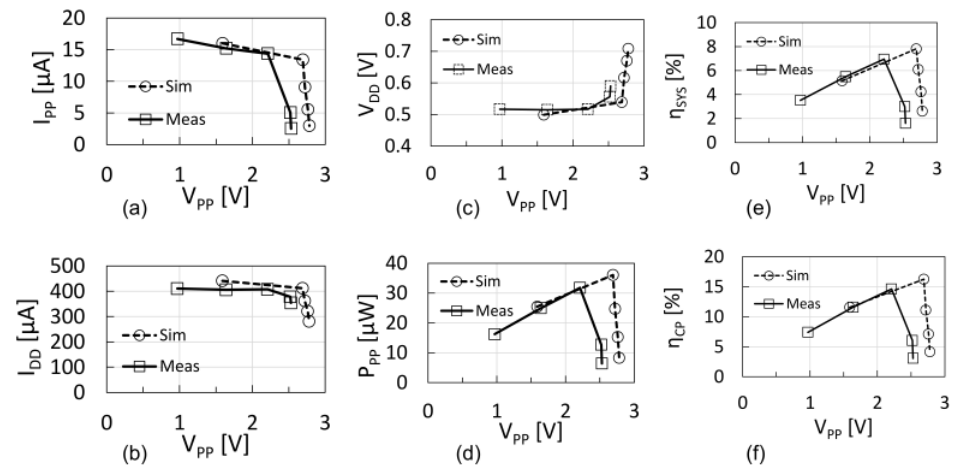
Figure 12. ( a ) I PP , ( b ) I DD , ( c ) V DD , ( d ) P PP , ( e ) h SYS , and ( f ) h CP as a function of V PP